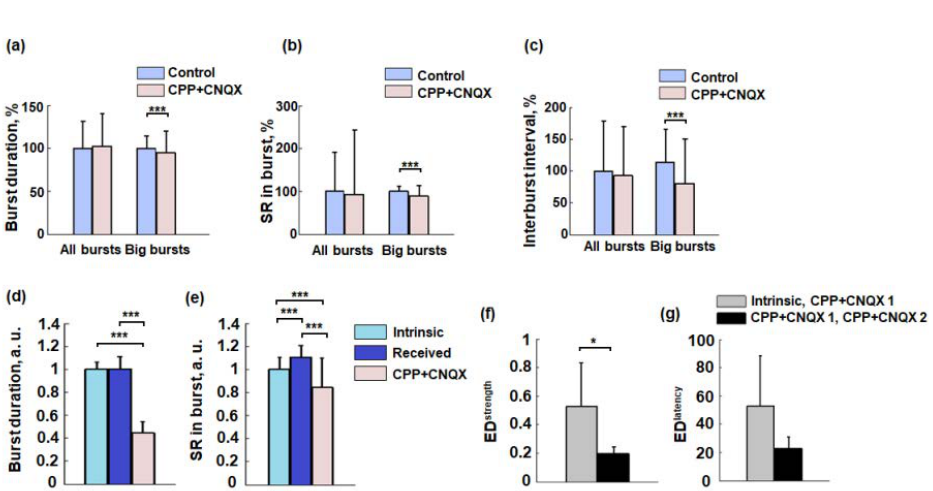
Figure 3. Spontaneous activity before and after suppression of excitatory synaptic activity in the Source chamber. ( a – c ) All spontaneous bursts and big spontaneous bursts duration, spiking rate in burst, and interburst interval in the Target chamber (median ± m.a.d., n = 6 experiments, Mann– Whitney test, *** p < 0.001). ( d , e ) Duration and spiking rate of the Intrinsic, Received big bursts under Control condition and big bursts under CPP + CNQX condition (see Methods) (median ± m.a.d., n = 6 experiments, Mann–Whitney test with Bonferroni correction, *** p < 0.001). ( f , g ) Functional connectivity changes measured by Euclidean distance between connectivity strengths (ED strength ) and connectivity latencies (ED latency ) (see Section 2). Connectivity was compared for two sets of the big bursts (Intrinsic, CPP + CNQX 1) and (CPP + CNQX 1, CPP + CNQX 2) (median ± m.a.d., n = 6, Wilcoxon rank-sum test, * p <